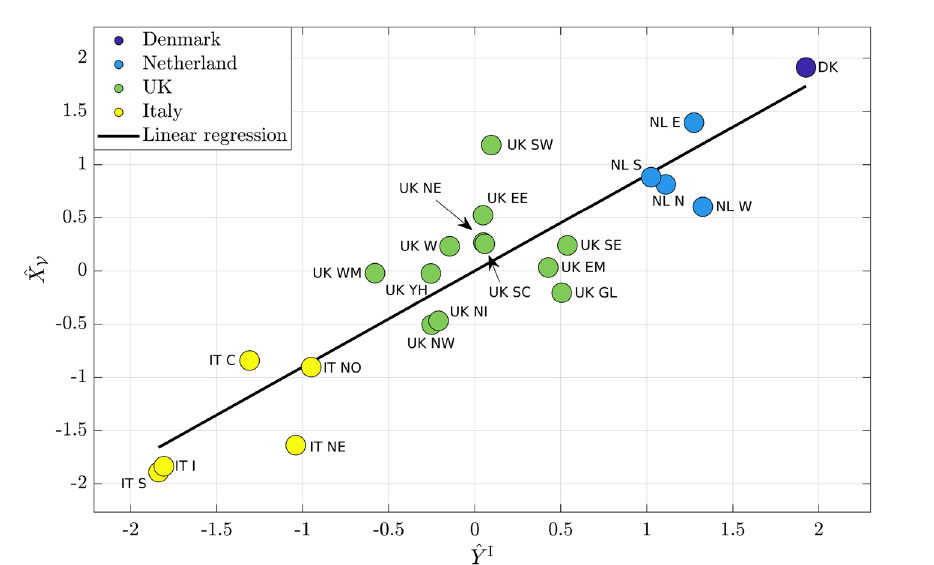
Figure 4. Comparison of standardized dataset ˆ σ I with standardized simulation ˆ σ X V